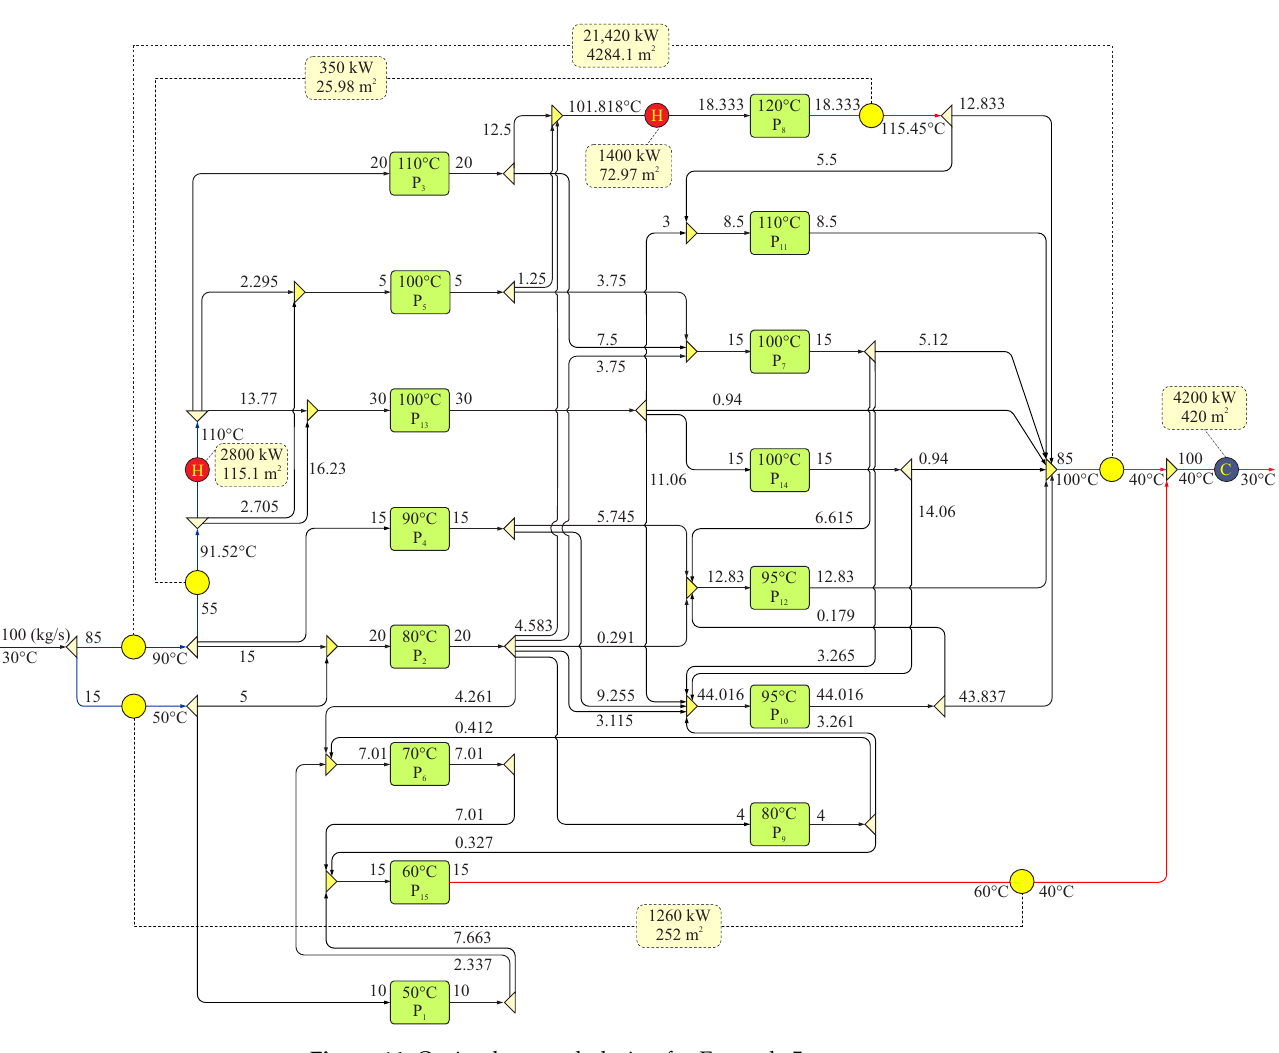
Figure 14. Optimal network design for Example